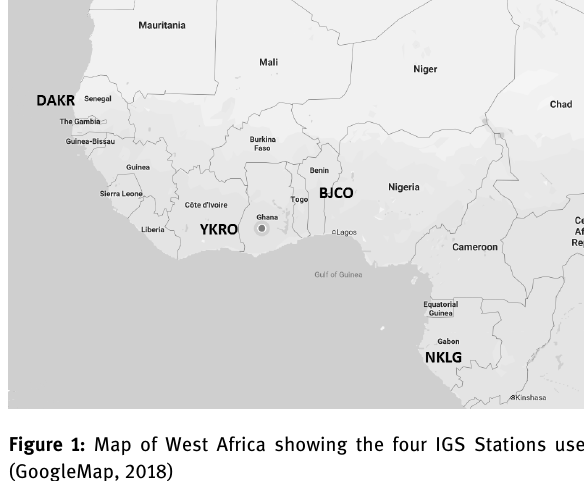
Figure 1: Map of West Africa showing the four IGS Stations used (GoogleMap,